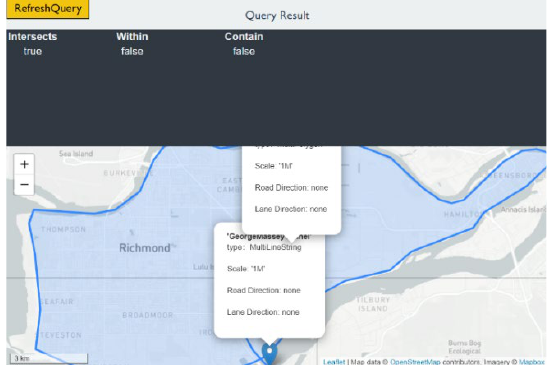
Figure 14 . Spatial relationship between LuluIsland and George Massey Tunnel. Since they only intersect with each other, Contains and Within are displayed as “False”.